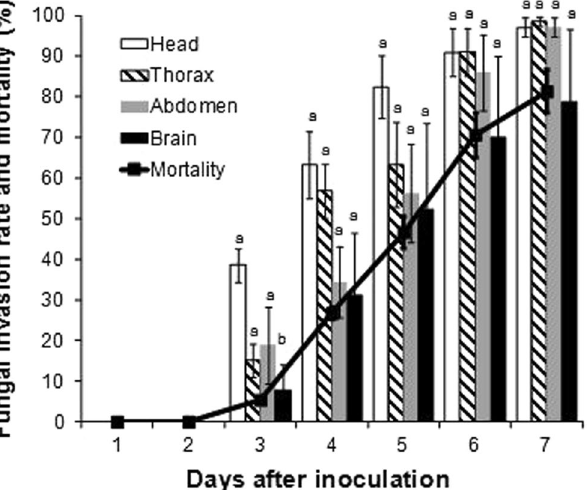
Figure 5. Mean rate of fungal invasion of each mosquito body part and mortality. Fungal invasion of each body part of mosquitoes was evaluated from Day 1 to Day 7 after inoculation, and mortality (%) of Anopheles stephensi was monitored until Day 7 after inoculation. Head refers to the head part on the outside of the brain. Lowercase letters indicate significant differences among the body parts (n = 30, p < 0.05, Tukey’s honest significant difference